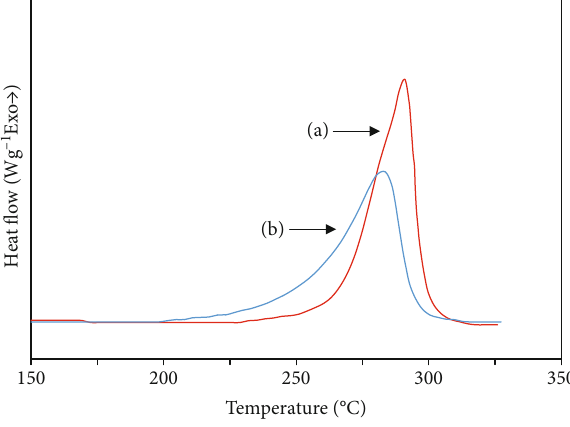
Figure 9: DSC of FPAN in air. (a) FCOM and (b) FPRE.